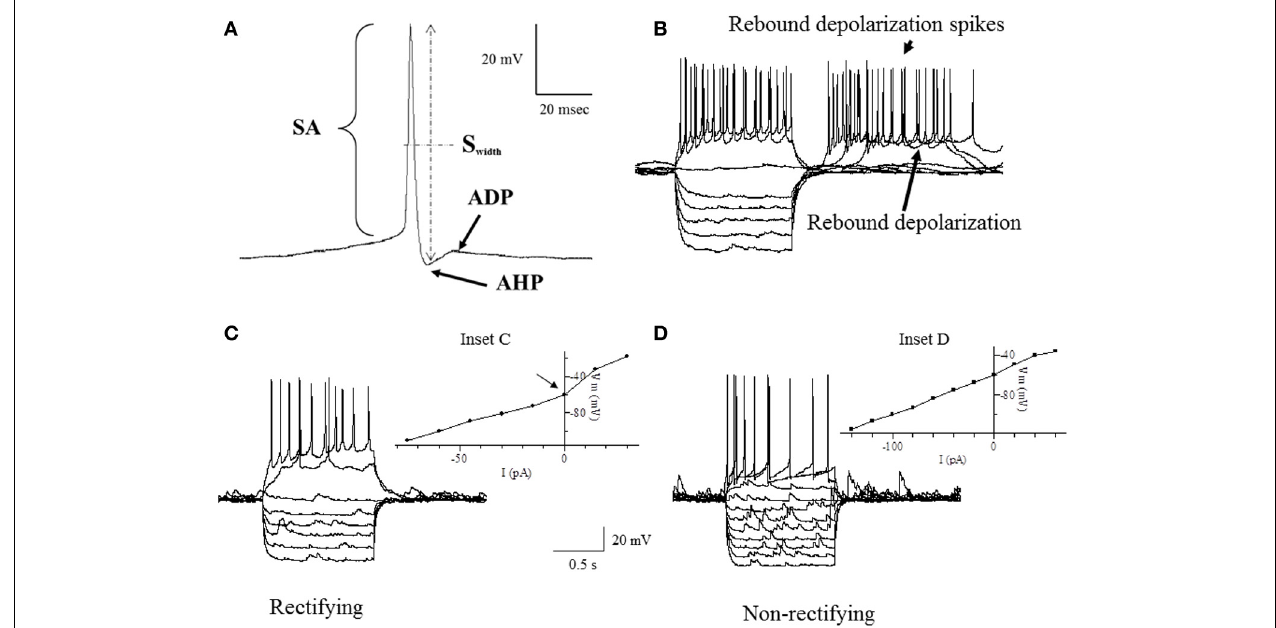
FIGURE 1 | Traces of some of the intrinsic membrane properties used in our statistical analyses. (A) Depicts the AHP (after hyperpolarization potential), APA (action potential amplitude), APD (action potential duration) and ADP (after depolarization potential). (B) Shows the RD (rebound depolarization) and RDS (rebound depolarization spikes). (C,D) demonstrate